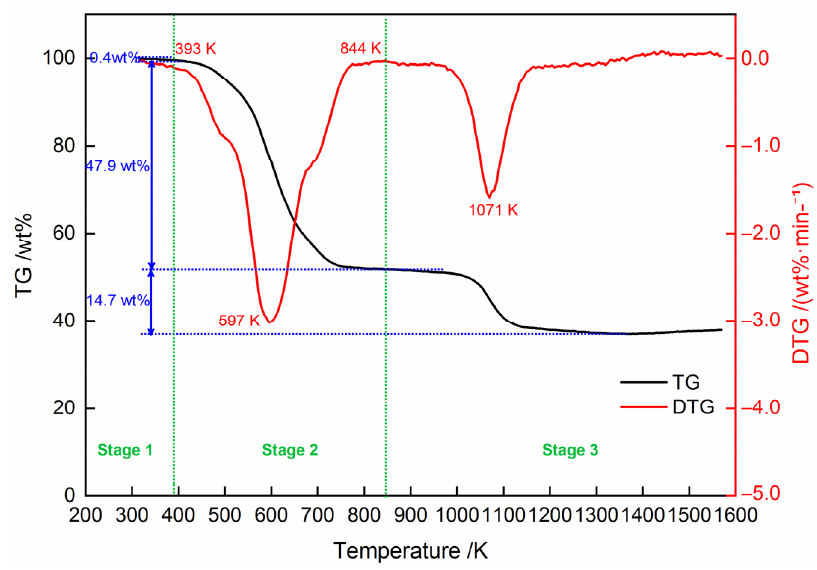
Figure 4. TG and DTG curves of the dried cold-rolling oily sludge heated in helium at the heating rate of 10 K/min.